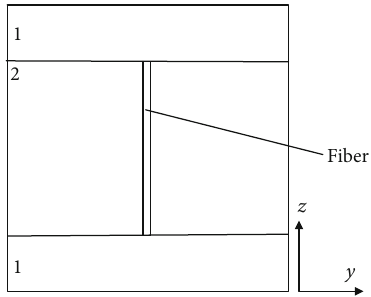
Figure 14: Unit cell model considering the fi ber size.